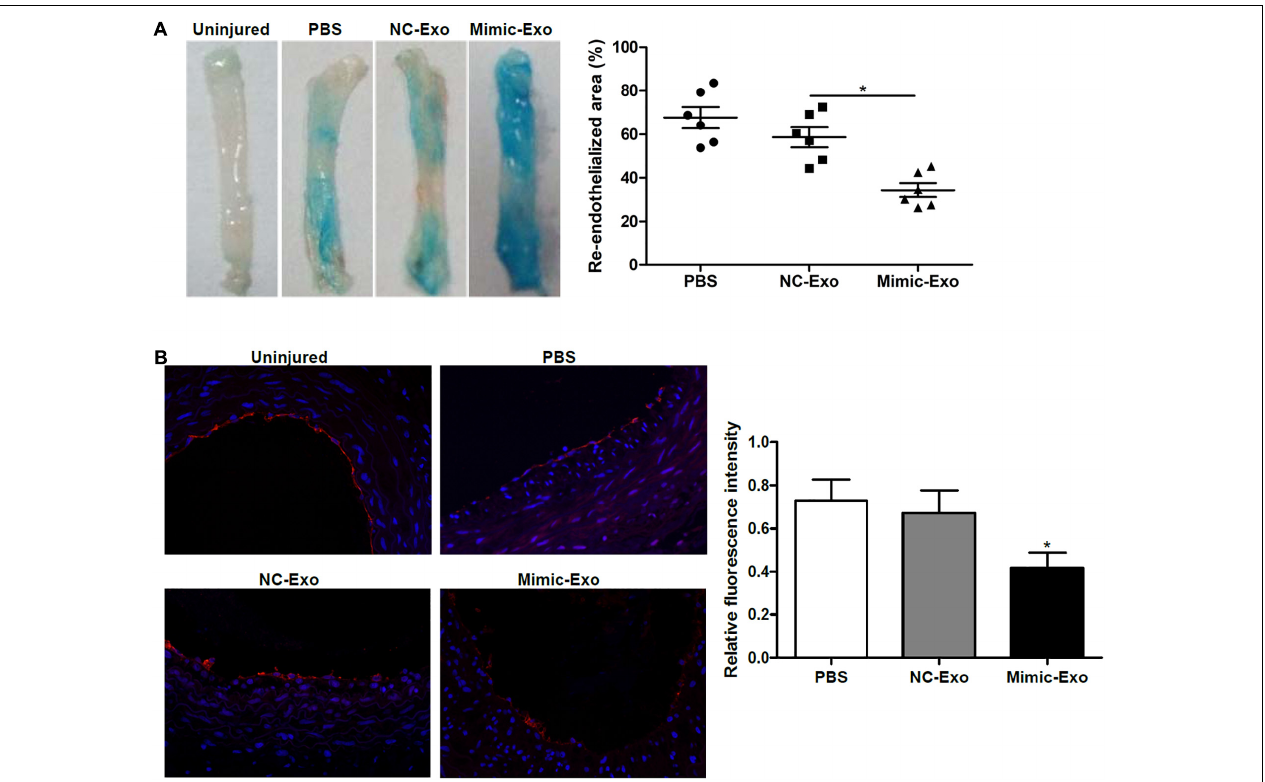
FIGURE 4 | Exosomal miR-185 derived from VSMCs attenuates re-endothelialization in balloon-injured rat carotid arteries. (A) Representative images of Evan’s blue staining of carotid arteries from rats treated with exosomes derived from miR-185 mimic transfected VSMCs at day 7 after balloon injury. The percent area of re-endothelialization was quantified as white-area/total-area ratio. (B) Immunofluorescence staining for CD31 in the sections at 1 week after injury. The relative fluorescence intensity is shown. * P < 0.05 vs.